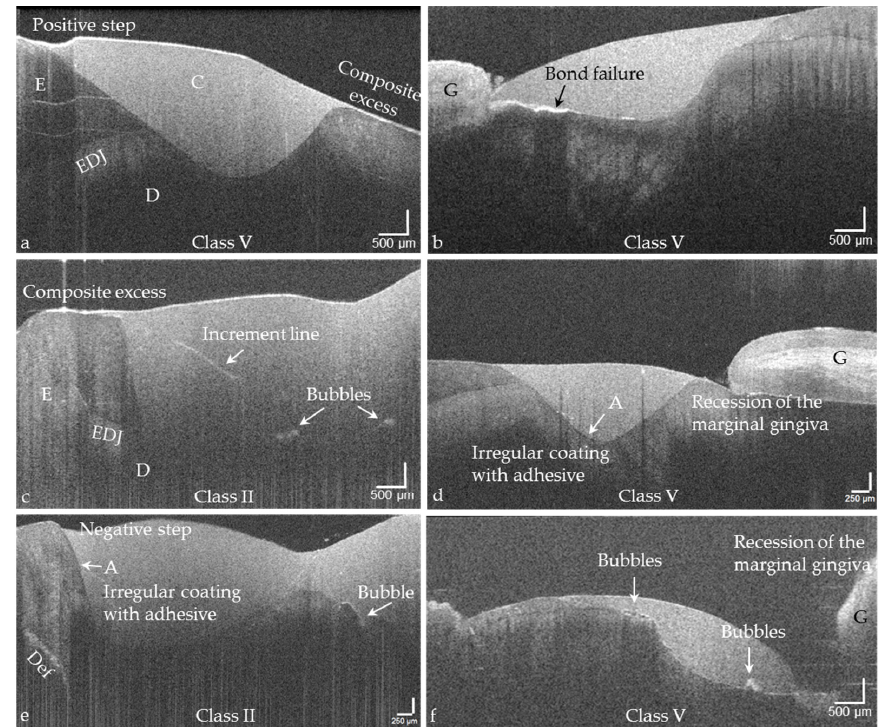
Figure 14. Exemplary OCT images of structural features in Class II and V composite restorations (C) that determine their functionality and are essential for the evaluation of the restorations. ( a ) Positive step and composite excess at the restoration margins, ( b ) interfacial adhesive defect (bond failure), ( c ) composite excess at the restoration margin, increment lines and bubbles in the restoration material, ( d ) irregular coating of the cavity with adhesive (A) and recession of the marginal gingiva (G), ( e ) negative step at a restoration margin, irregular coating with adhesive and bubble in the restoration material, ( f ) bubbles in the restoration and recession of the marginal gingiva. Enamel (E), dentin (D), the enamel-dentin junction (EDJ), cohesive defect (Def). The vertical scales are related to the refractive index n = 1.0 (see remark in Figure 4).